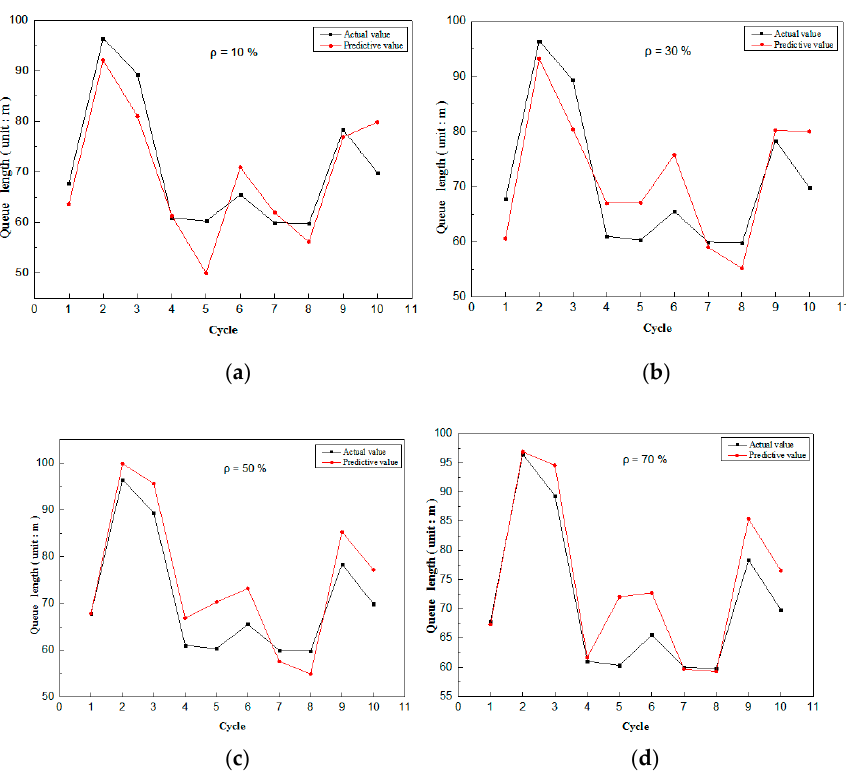
Figure 8. Schematic diagram of combined model prediction results when penetration rate ρ = 10% ( a ), penetration rate ρ = 30% ( b ), penetration rate ρ = 50% ( c ) and penetration rate ρ = 70% ( d ).